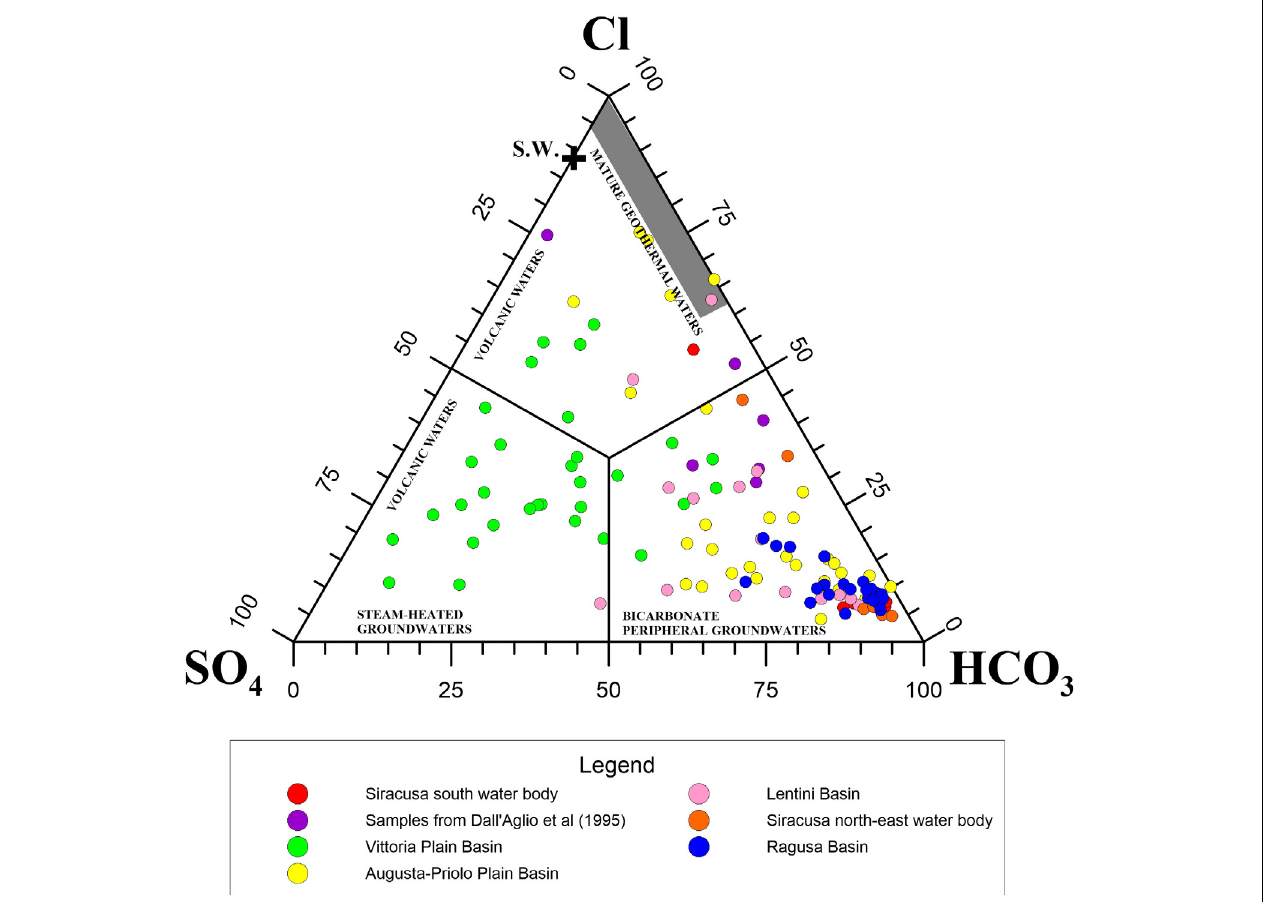
FIGURE 4 | Ternary plot Cl-SO 4 -HCO 3 . The graph displays that (i) most of the waters fall close to the HCO 3 - vertex, typical of groundwaters from rock-weathering; (ii) all of the samples from the Vittoria basin (green circles) are highly enriched in SO 42 - , likely because of pollution due to agricultural activities related to wine production; (iii) some samples trend toward the composition typical of mature geothermal waters. The association of colors to sites is the same as in Figure 3 .